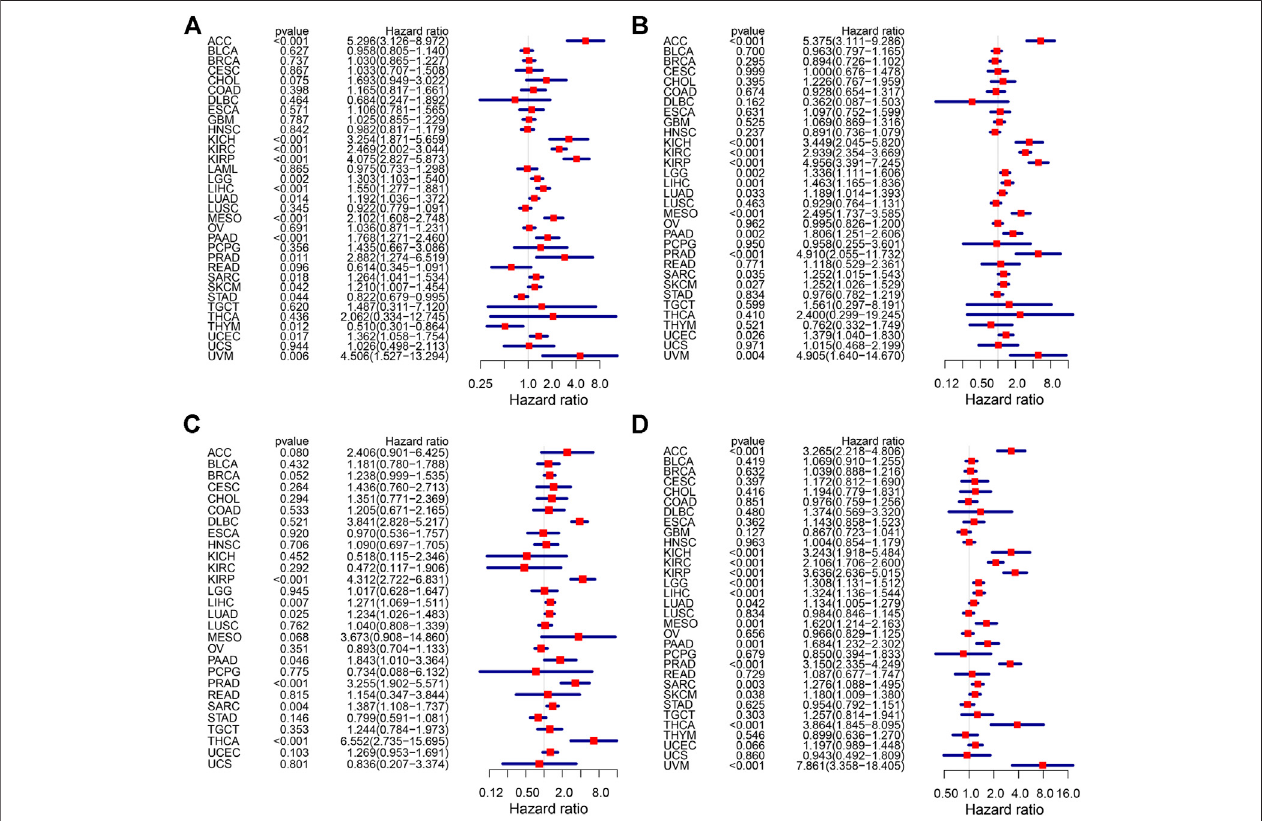
FIGURE 2 | The effect of KIF18B on the prognosis of various cancers using Cox proportional hazards models. (A) The effect of KIF18B on OS in 33 types of cancers. (B) The effect of KIF18B on DSS in 33 types of cancers. (C) The effect of KIF18B on DFS in 33 types of cancers. (D) The effect of KIF18B on PFI in 33 types of